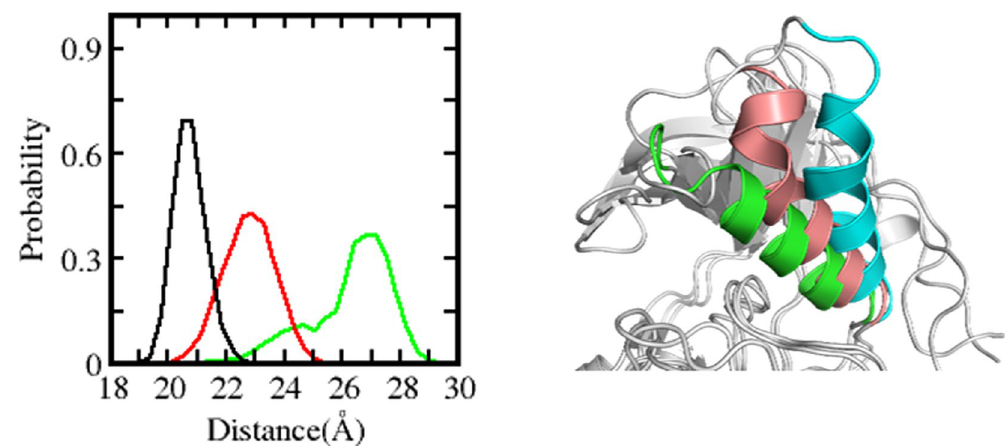
Figure 2. Distribution of ligand binding pocket size. Left: Distances between α C-helix and binding site of conformations sampled during the MD simulations of EGFR WT (green), EGFR L858R (red) and EGFR 19del (black) in their apo states; Right: Snapshot of EGFR WT (cyan), EGFR L858R (brown) and EGFR 19del (green) highlighting the movement of α C-helix during the MD